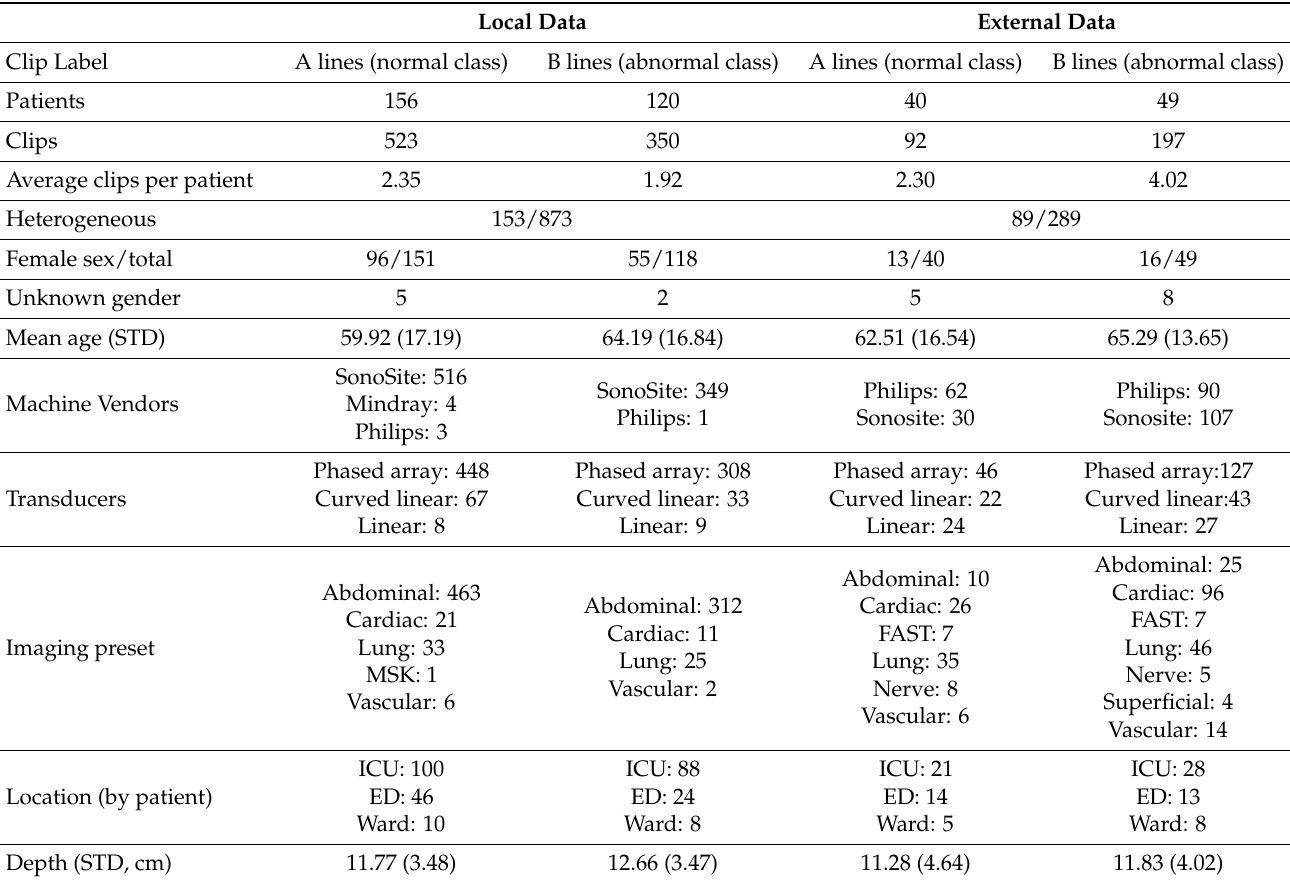
Table 2. Data characteristics for clip-based inference ultrasound clips. ED, emergency department; ICU, intensive care unit.